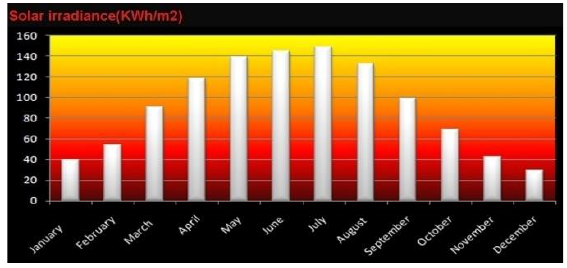
Figure 5. Monthly average solar irradiance variation at site level per month.